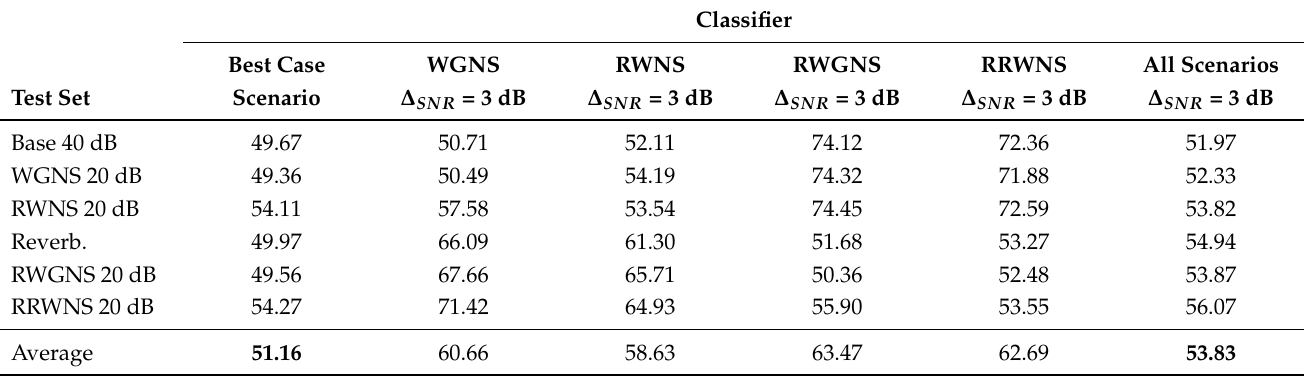
Table 7. Third stage experiments results. Error probability (%) cross results within different scenarios